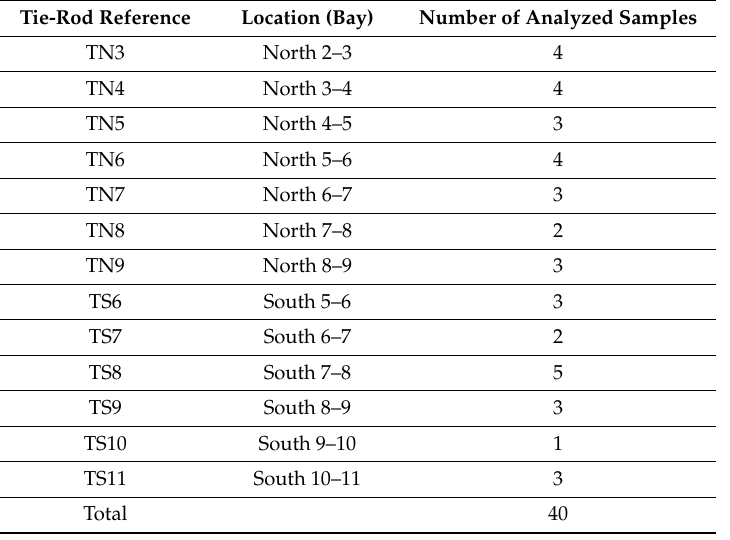
Table 2. Samples of the iron